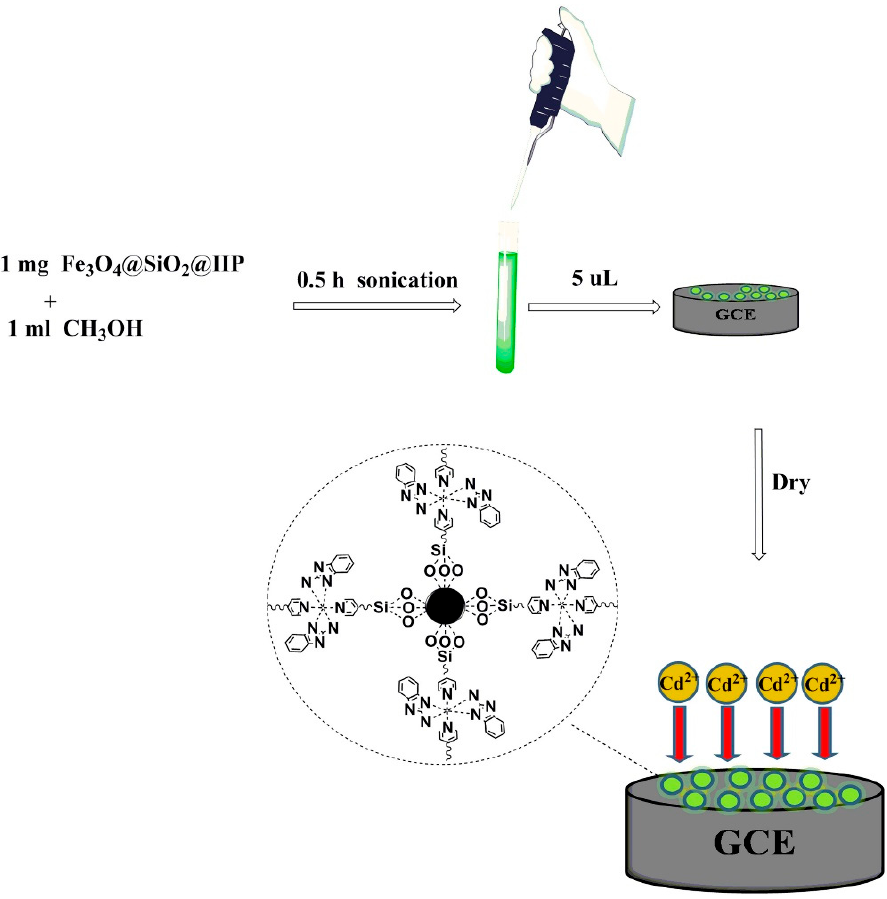
Figure 14. Schematic diagram of Fe 3 O 4 @SiO 2 @IIP modified GCE. Reprinted with permission from